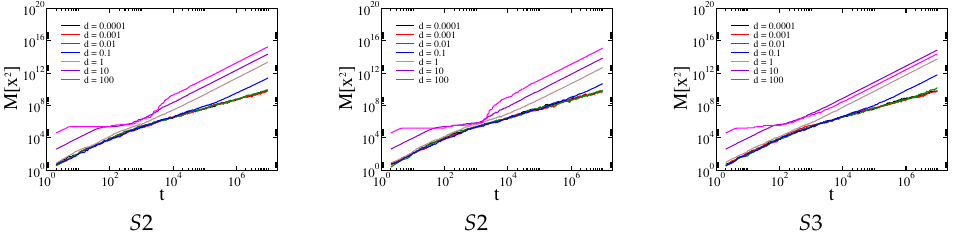
Figure 8. Dependence of the median of the square displacement x 2 on the time driven by Cauchy flights moving in the structures S1, S2, and S3, respectively.